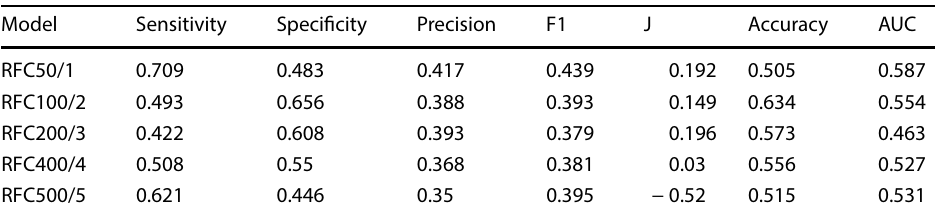
Table 7 RFC average with 3 classes (testing)